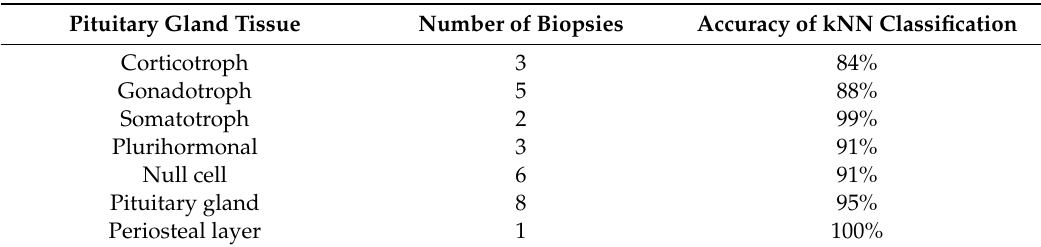
Table 2. Overview of investigated adenoma types and statistics fed into the PCA and kNN. Pituitary Gland